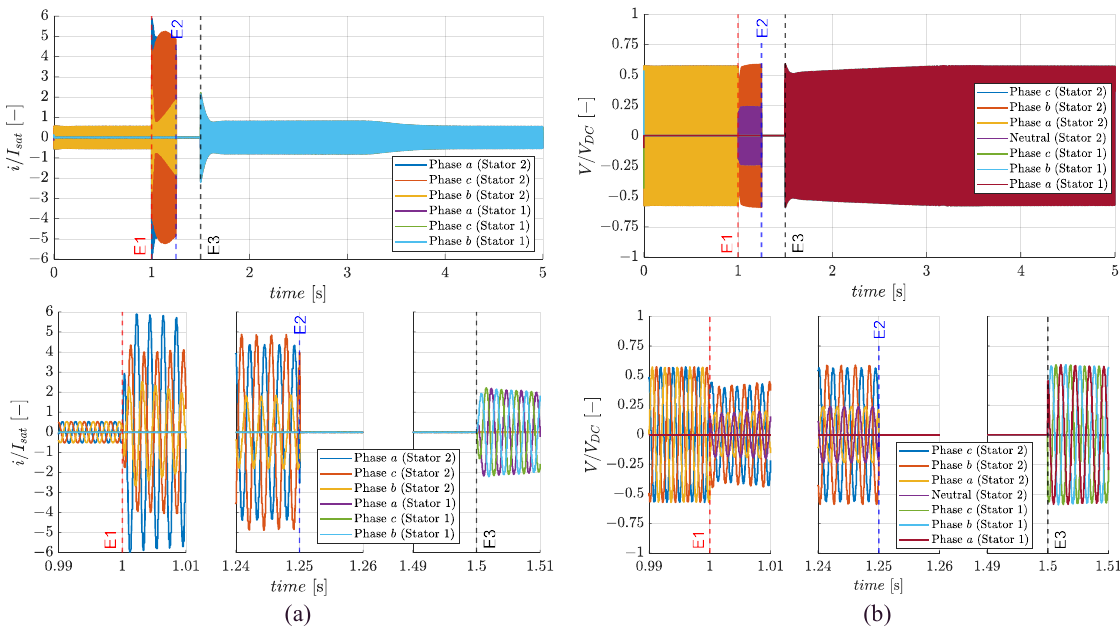
Figure 14. FEPS currents and voltages responses in cruise with phase-to-ground fault on stator 2 (E1, E2 and E3 defined in Section 3.1): stator 2 currents ( a ) with I sat = 46 Arms; stator 2 voltages ( b ) with V DC = 36